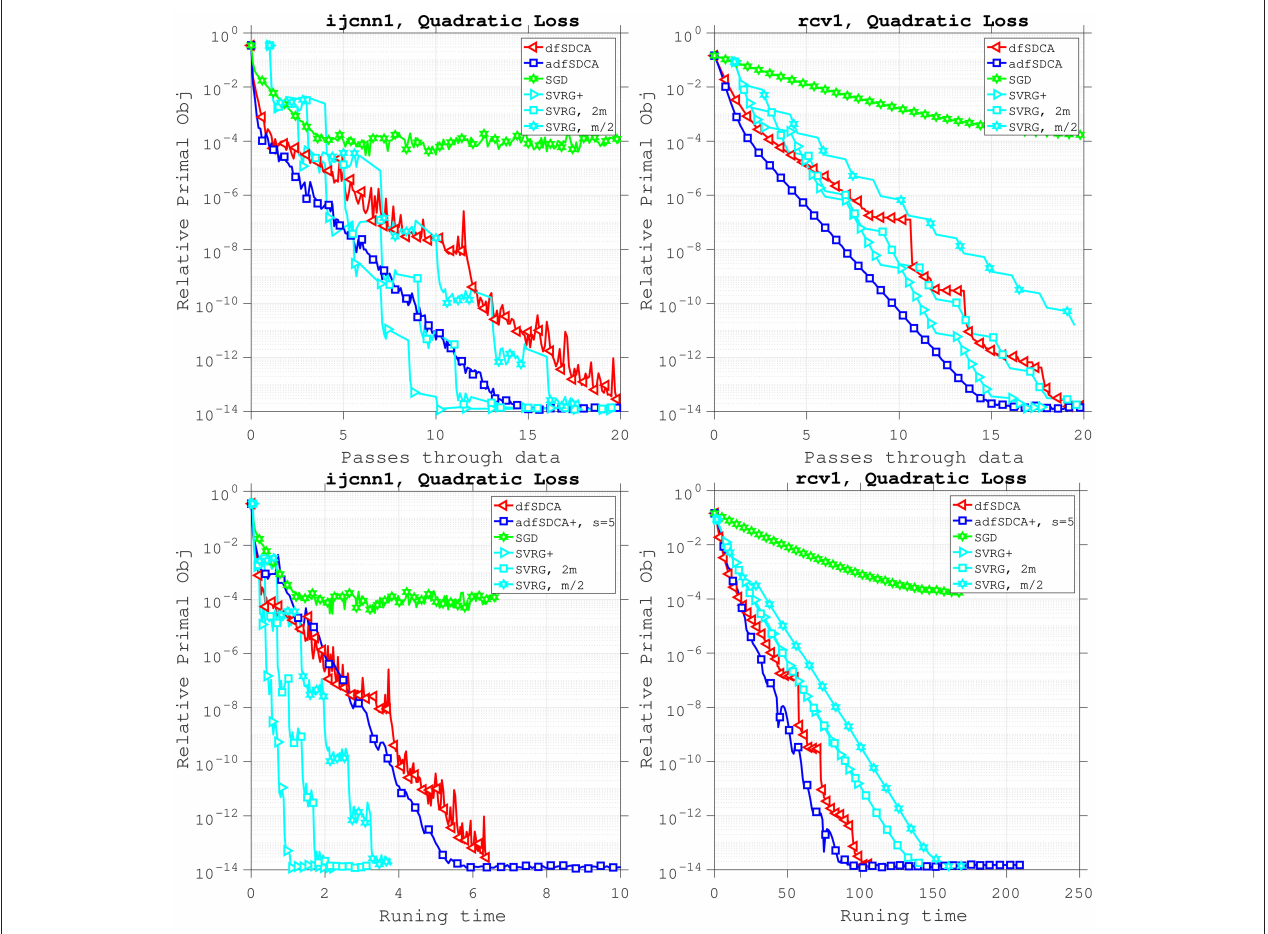
FIGURE 3 | A comparison of the number of epochs versus the relative primal object value for SGD, dfSDCA, adfSDCA(+) and SVRG. SVRG+ denotes the parameter-tuned, best performing SVRG algorithm, where m denotes the corresponding number of inner loop iterations. We also show results for the SVRG agorithm using both m / 2 and 2 m inner loop iterations, to demonstrate the performance of SVRG without optimal tuning.